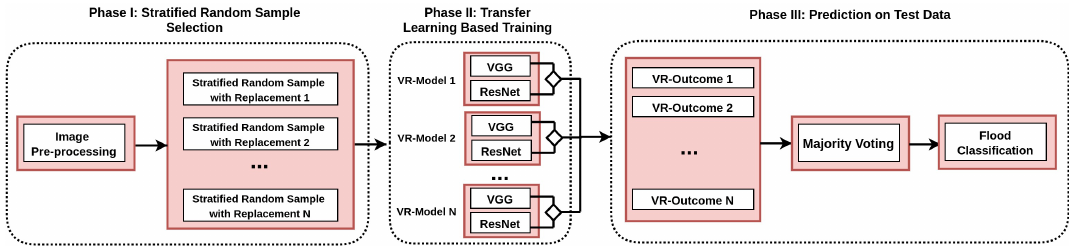
Figure 1. Proposed Framework of